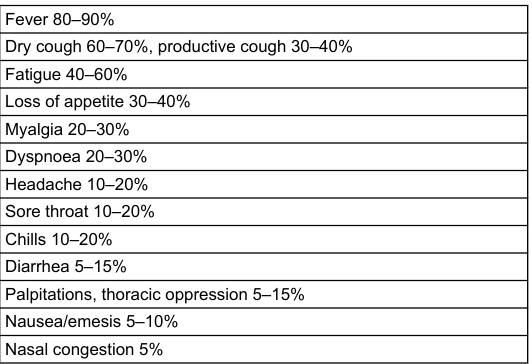
Table 1: Frequency of clinical symptoms of COVID-19.